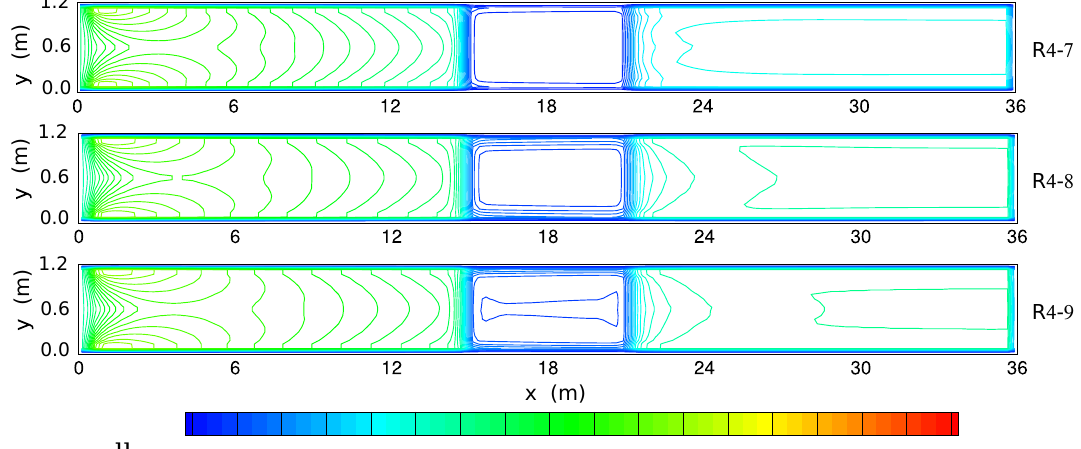
Figure 6. U velocity component at 0 . 176 m, 0 . 208 m and 0 . 215 m from the bottom, for the cases R4-7, R4-8 and R4-9, respectively. Where u